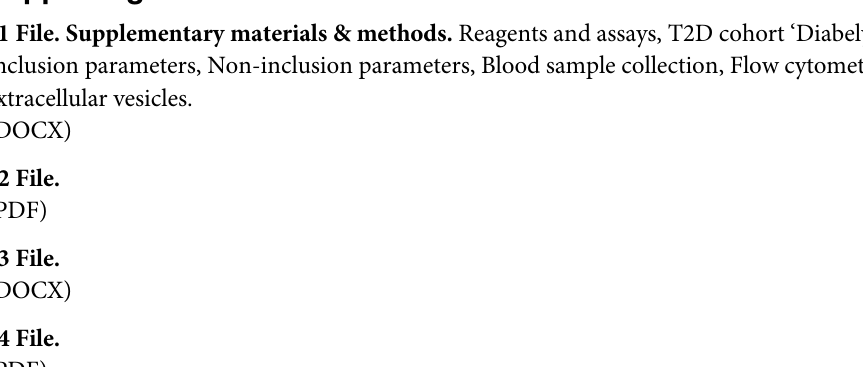
S1 Table. Baseline clinical and biological characteristics of patients included in the Dia- belyse study. The table lists the clinical data that were significantly associated with T2D in cohort Diabelyse, in univariate and multivariate analyses. Those included classical traits of